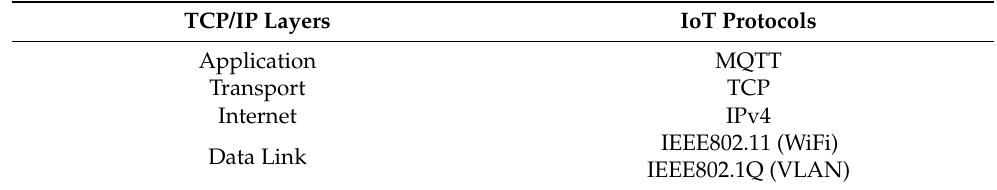
Table 2. Summary of protocol